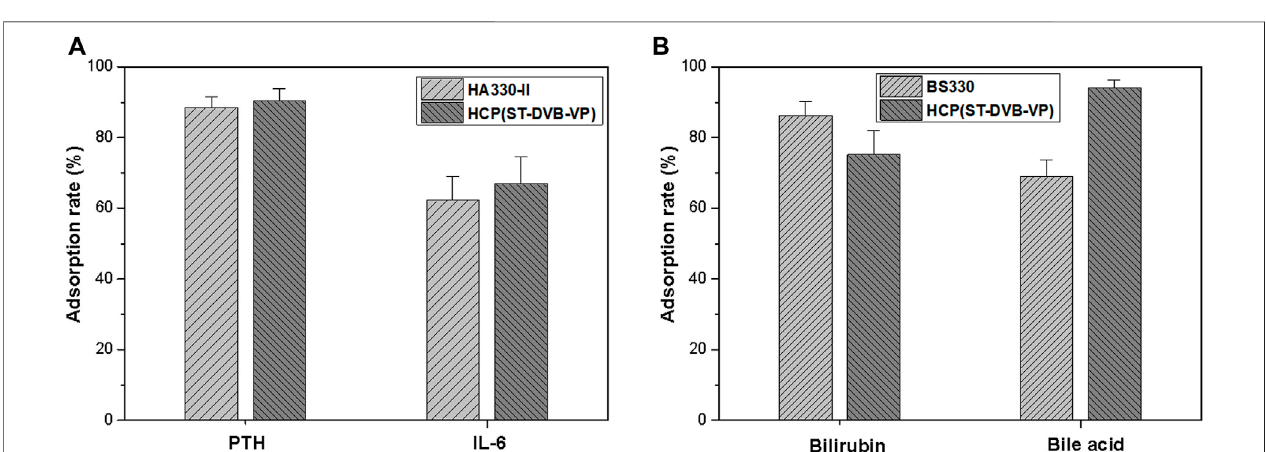
FIGURE 6 | Adsorption rates of (A) medium-sized molecular uremic toxins and (B) protein-bound toxins in the human plasma after 2 h of treatment. The initial concentrations of PTH, IL-6, bilirubin, and bile acid were 180 pmol L − 1 , 300 pg ml − 1 , 300 μ mol/L and 150 μ mol/L, respectively. The data are expressed as the mean ± SD of three independent